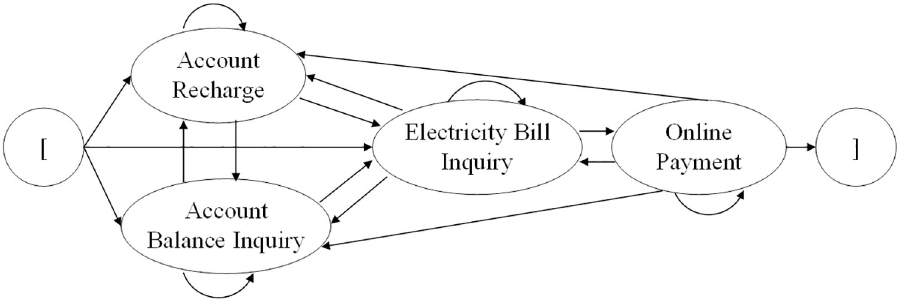
Fig 7. ESG of a simplified electricity bill payment